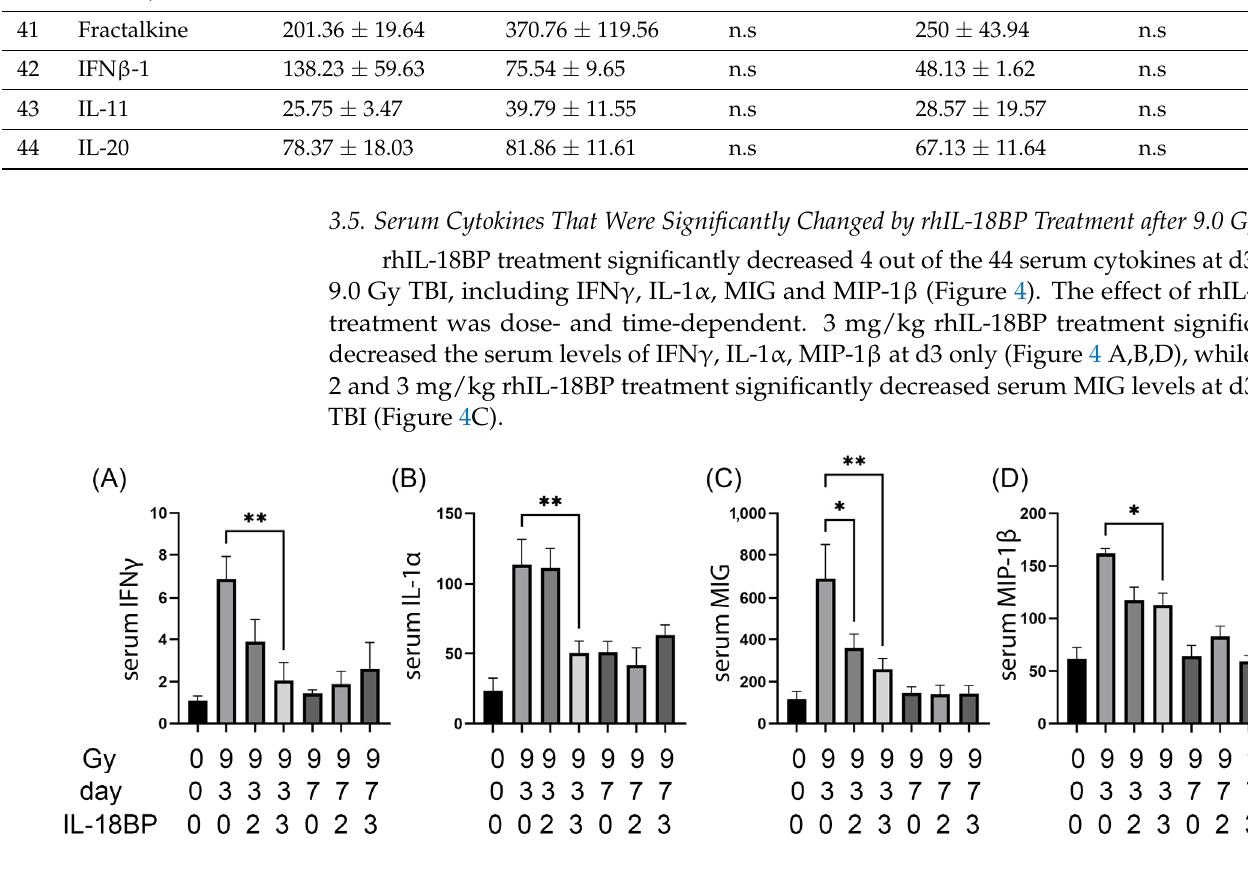
Figure 4. Serum cytokines that were significantly changed by rhIL-18BP treatment after irradiation. Radiation dose, time points after irradiation, and rhIL-18BP dose (mg/kg) were shown below the graphs. ( A ) serum IFN γ levels, ( B ) serum IL-1 α levels, ( C ) serum MIG levels, and ( D ) serum MIP-1 β levels. All cytokines’ concentration unit was pg/mL. 0 Gy samples were not included for statistical analysis to simplify the view. *, p < 0.05; **, p <